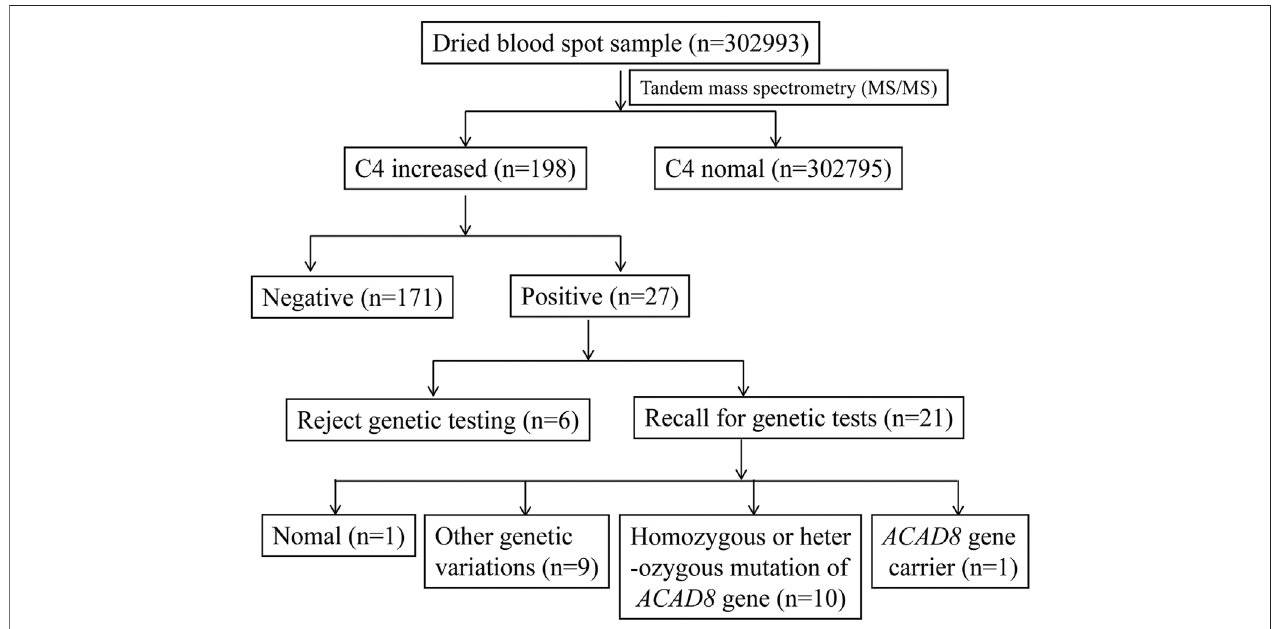
FIGURE 1 | Flow chart of newborn screening and